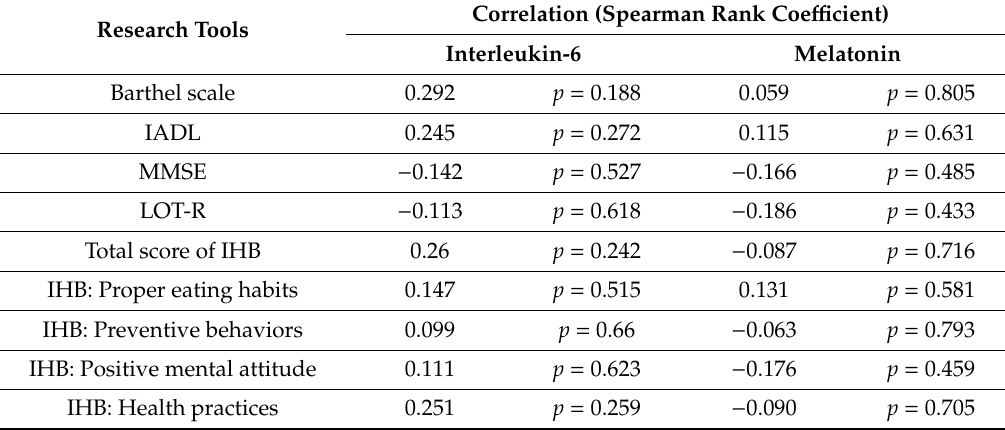
Table 5. The relationship between the level of interleukin-6 and melatonin and the results obtained from standardized research tools among respondents aged 60–75 belonging to the study group (n = 66).